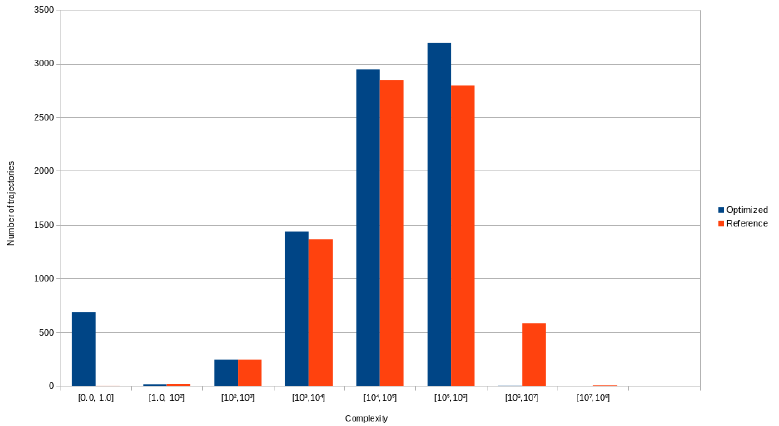
Figure 11. Comparison of the complexity of each trajectory before and after using only departure time